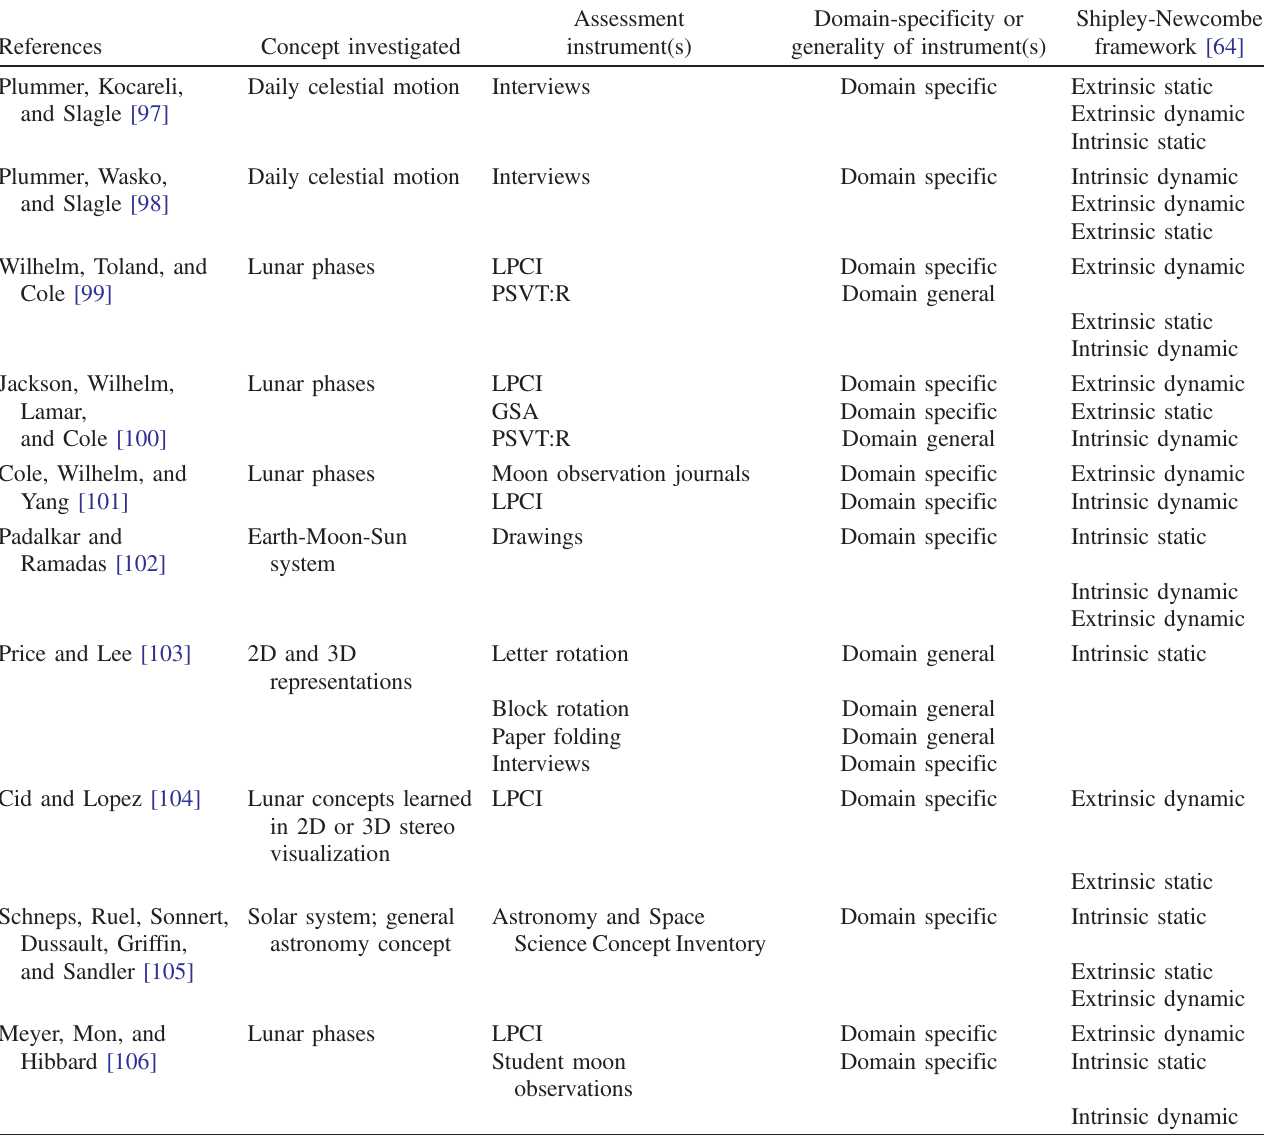
TABLE VII. Newcombe-Shipley [64] categories for interventional